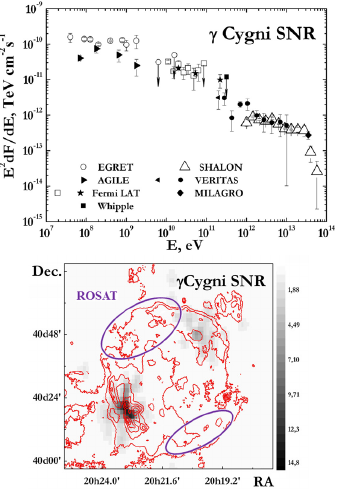
Figure 3. Characteristics of γ CygniSNR: top: Spectral energy distributions of high- and very high energy γ -ray emission by SHALON ( ) in comparison with other experiments. bottom: (cid:26) Image of SNR at energies > 0 . 8 TeV by SHALON (grey scale). Contours are 1420 MHz radio structure by CGPS. Five contour levels are linear scaled and correspond to 10%, 20%, 30%, 40%, 50% of the map